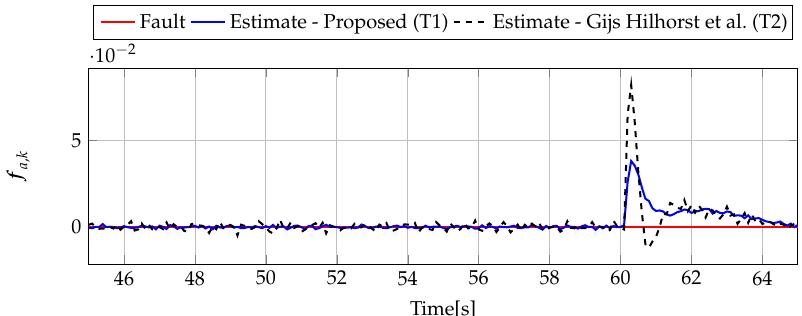
Figure 7. Fault f (red line) and fault estimate obtained with Theorem 1 (T1) and Theorem 2 (T2) a , k based on [39] for FS2 (for t = 45, . . . ,65 [s]) as well as the response for disturbance signal w 1, k .